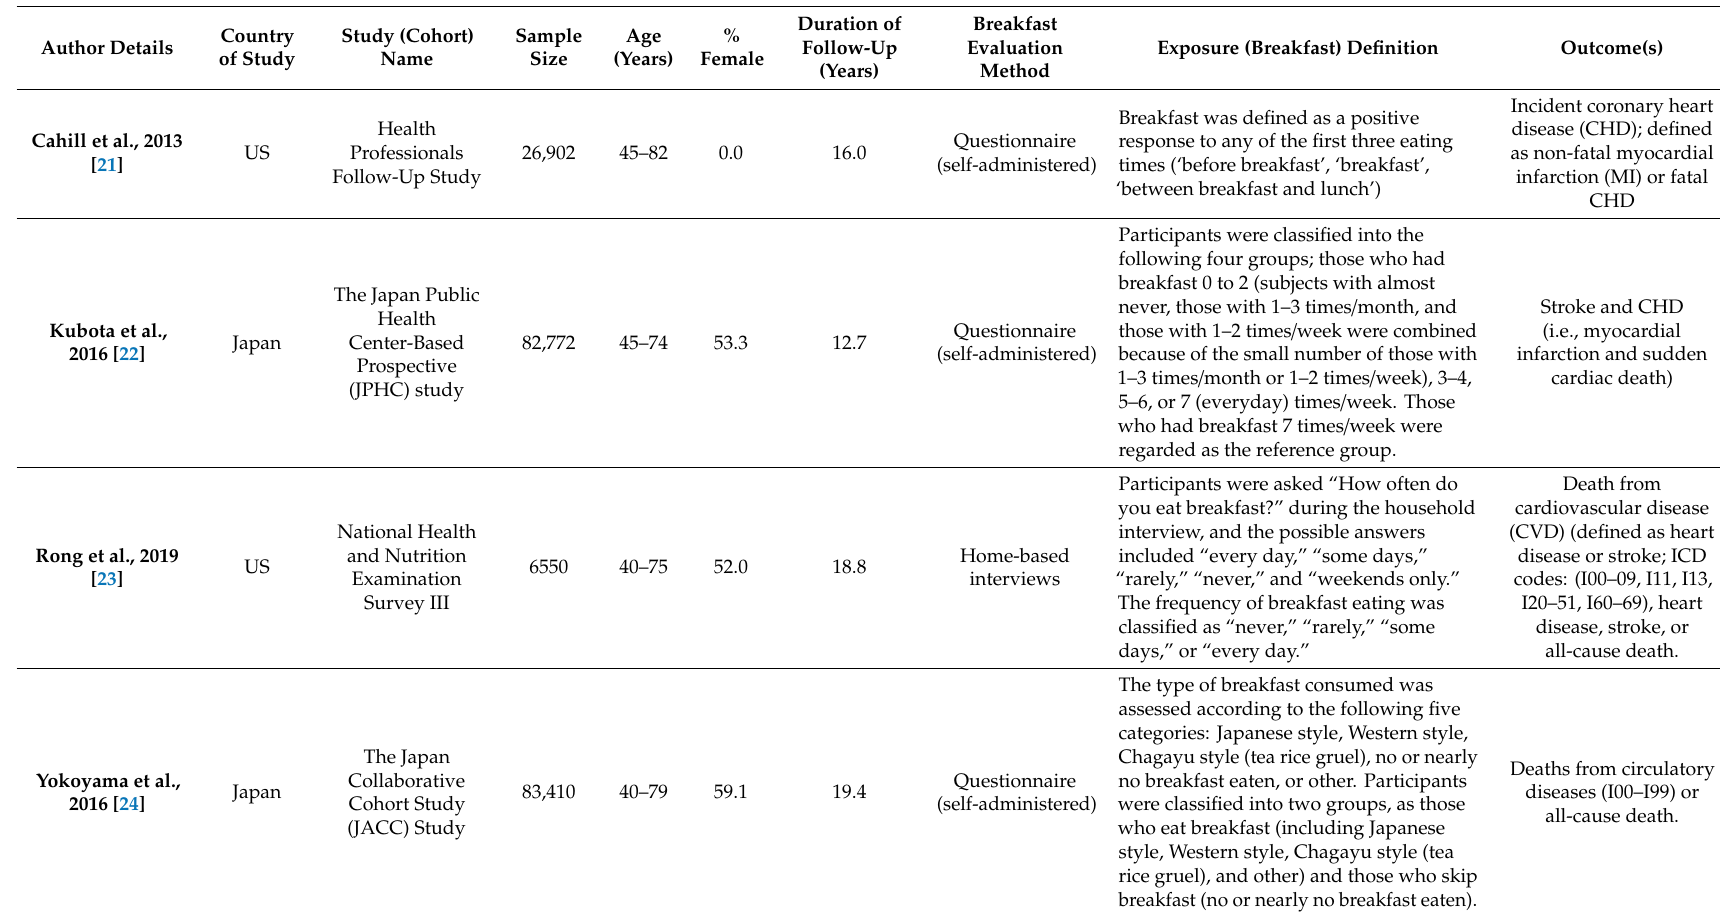
Table 1. Descriptive characteristics of included